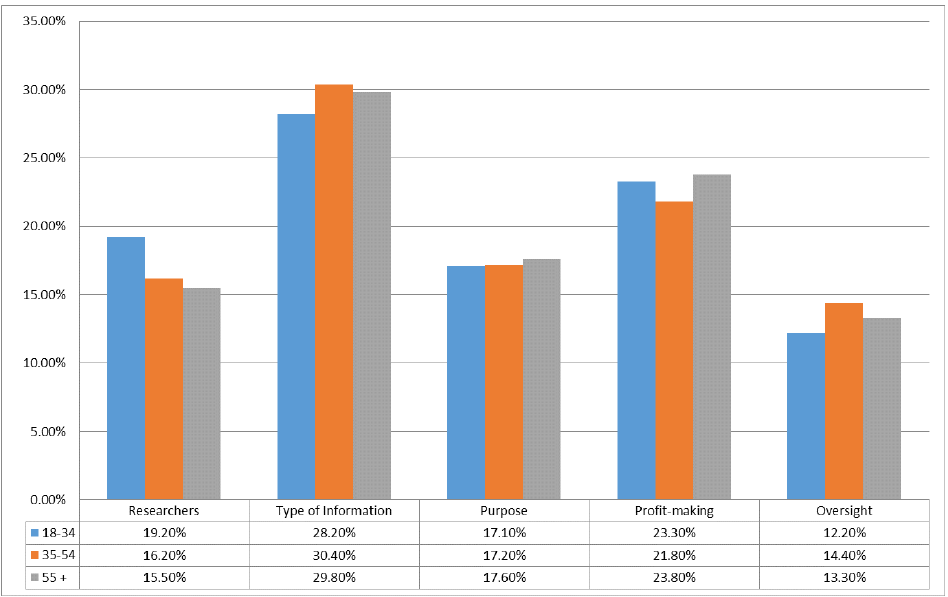
Figure 2: Relative Importance of Attributes for Respondents across Different Age Groups